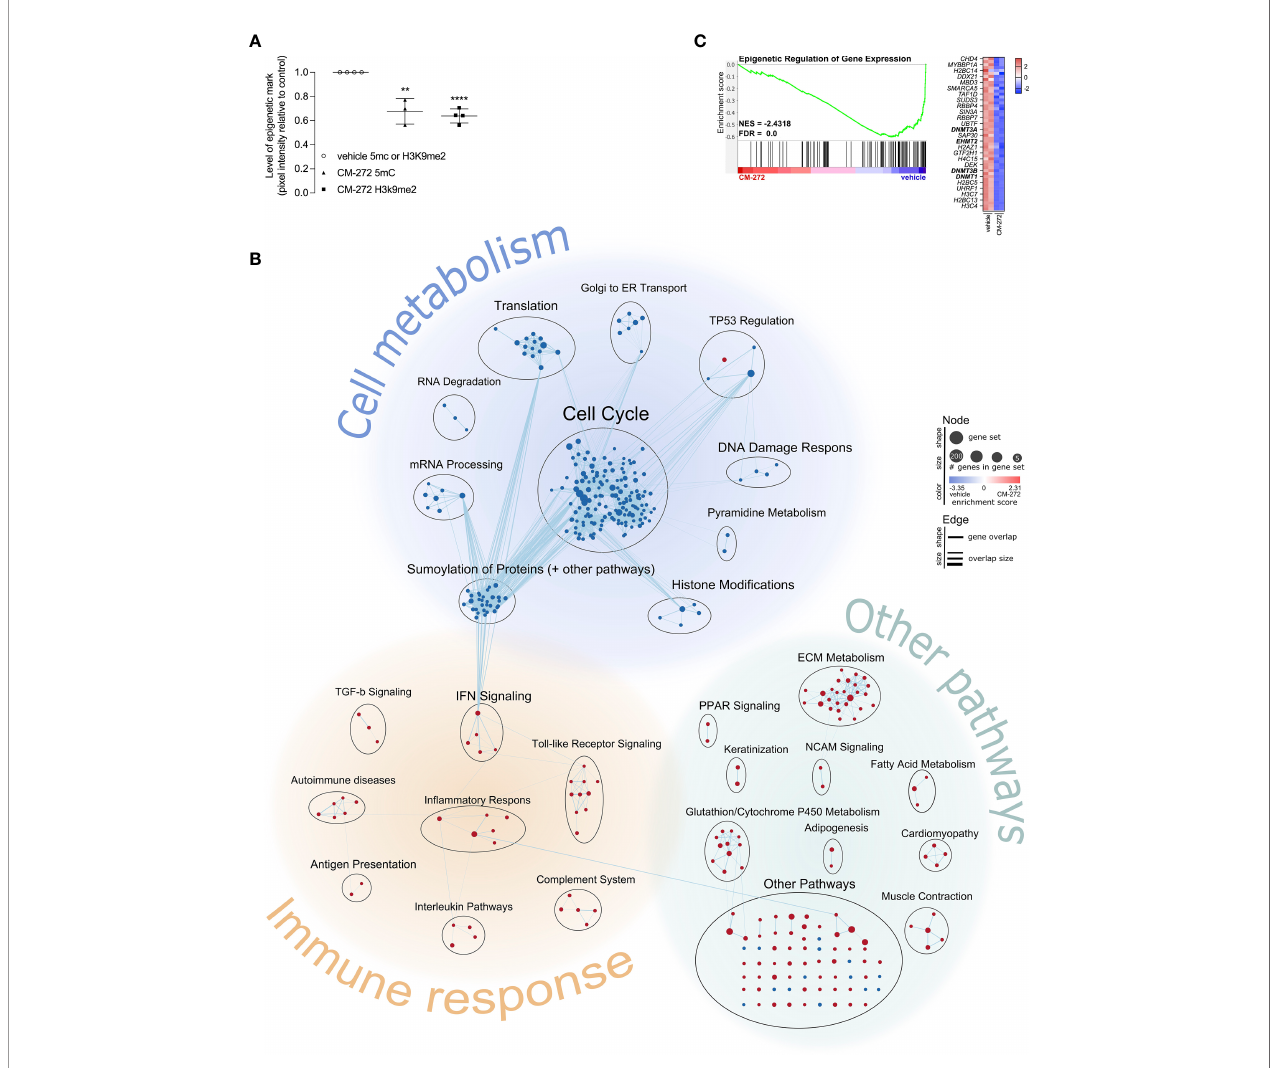
FIGURE 1 | Dual G9a and DNMT inhibition shapes the transcriptional pro fi le of melanoma cells, impacting on cell cycle progression and immunogenicity. (A) H3K9me2- and 5mC-levels upon 1.9 m M CM-272 treatment (2 or 5 days respectively), relative to vehicle-treated cells (mean ± SD; n =3/4). (B, C) Gene expression changes in MO4 cells upon treatment with 1 m M CM-272 for 24 hours ( n =1, 2 s.p.c.). The percentage of cells with fractionated DNA (sub-G1-phase, indicative of cell death) amounted to 1.78 ± 0.67 and 6.92 ± 2.32 (SD) in vehicle and CM-272 treated conditions, respectively. (B) Graphical representation of GSEA on gene expression changes in MO4 cells. (C) Enrichment plot of a gene set involving epigenetic regulation of gene expression. Heatmap lists row-normalized gene expression of leading-edge genes. Vehicle and CM-272 conditions were compared using unpaired two-tailed student t -test (A) . Asterisks indicate statistical signi fi cance: **p ≤ 0.01; ****p ≤